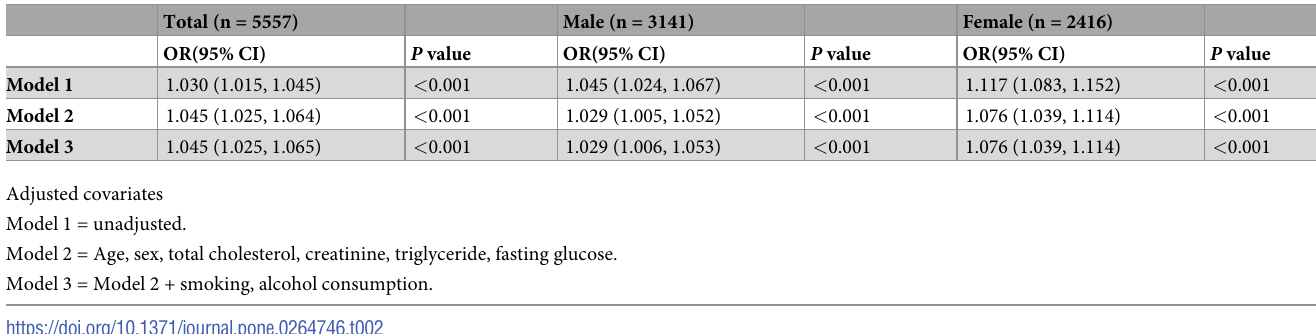
Table 2. Risks of diverticulosis between percentage of body fat and